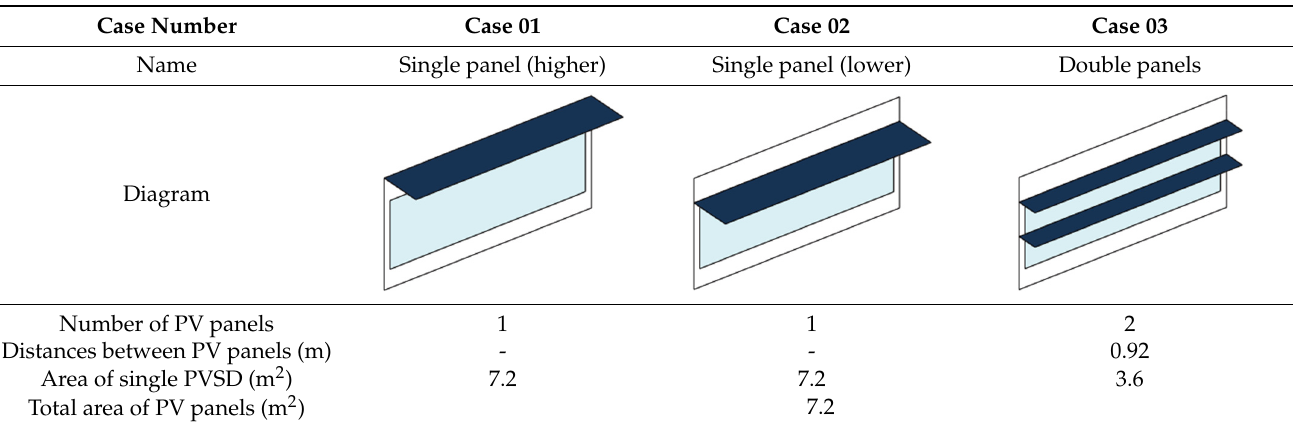
Table 1. Room modeling